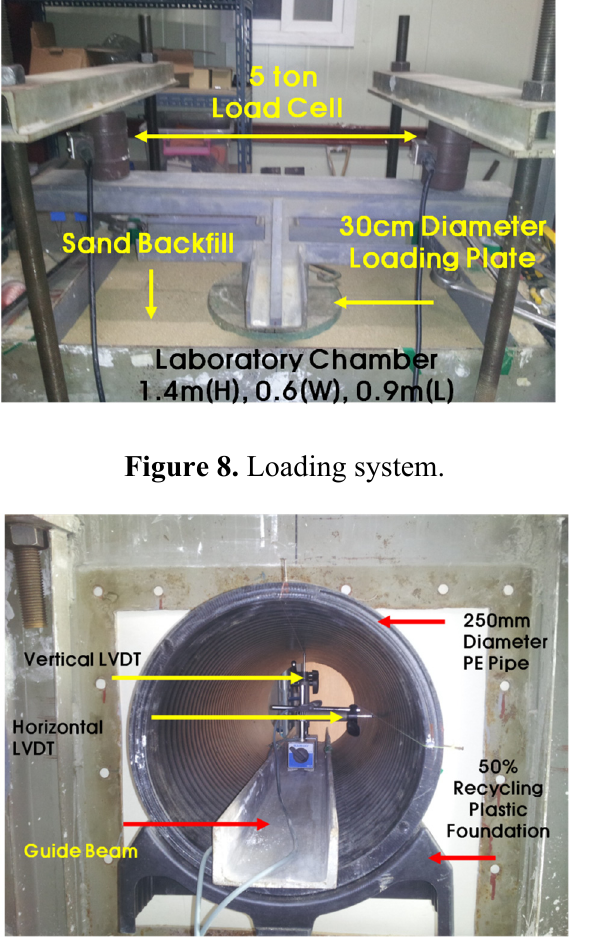
Figure 9. Setup of Linear Variable Differential Transducer